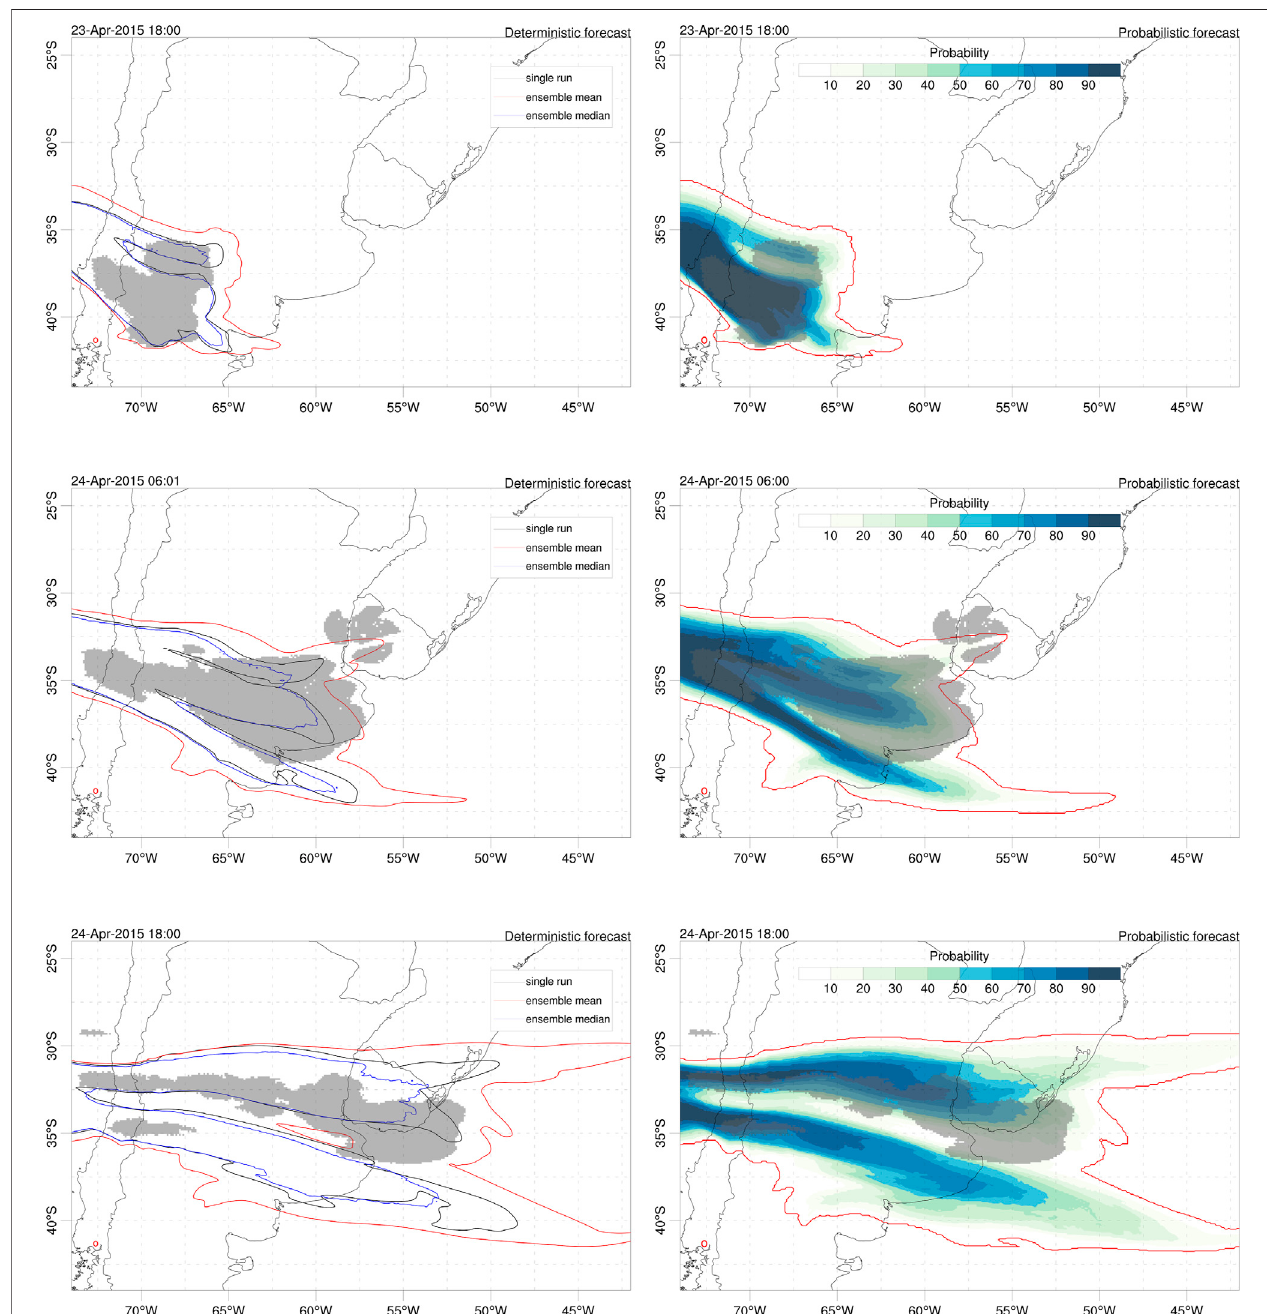
FIGURE 9 | Validation of Calbuco ash cloud with the satellite detection (SEVIRI ash fl ag) observation dataset. Model column mass contours of 0.1 g/m 2 for deterministic (left) and probabilistic (right) forecasts at three different instants; 23 April at 18:00UTC (top) , 24 April at 06:00 UTC (middle) and 24 April at 18:00UTC (bottom) .Intheprobabilisticplots,theouterredcontourindicatesthe1.56%(1/64)probability.TheshadedareasshowthecontoursencompassingSEVIRIash fl agged pixels. Red circle shows the location of Calbuco volcano.